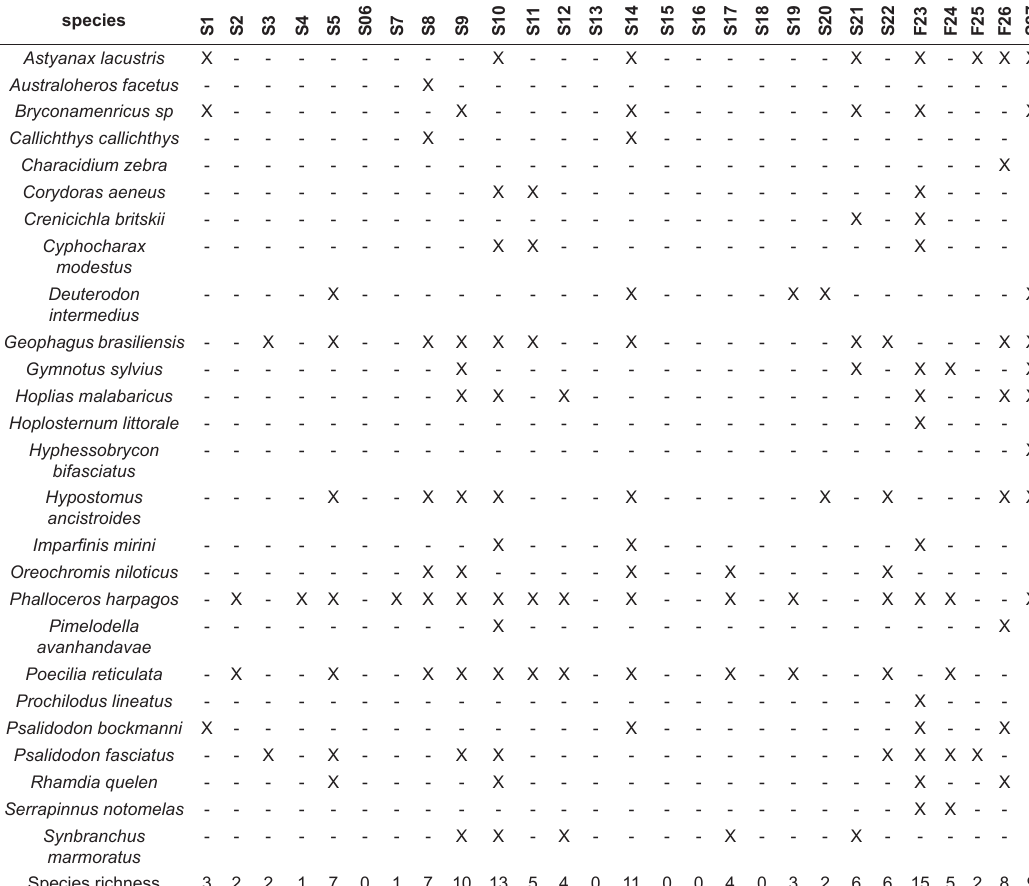
Table 5. Species richness and fishes from 27 stream stretches in the Sorocaba City (S) and FLONA-Ipanema (F) of the Medium Sorocaba River